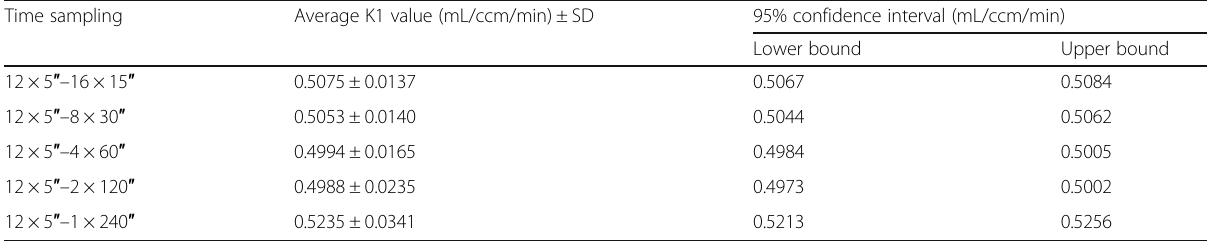
Table 3 Comparison of the results of K1 values from the 1000 simulations (Monte Carlo) for the five different time sampling simulated for the tissue phase